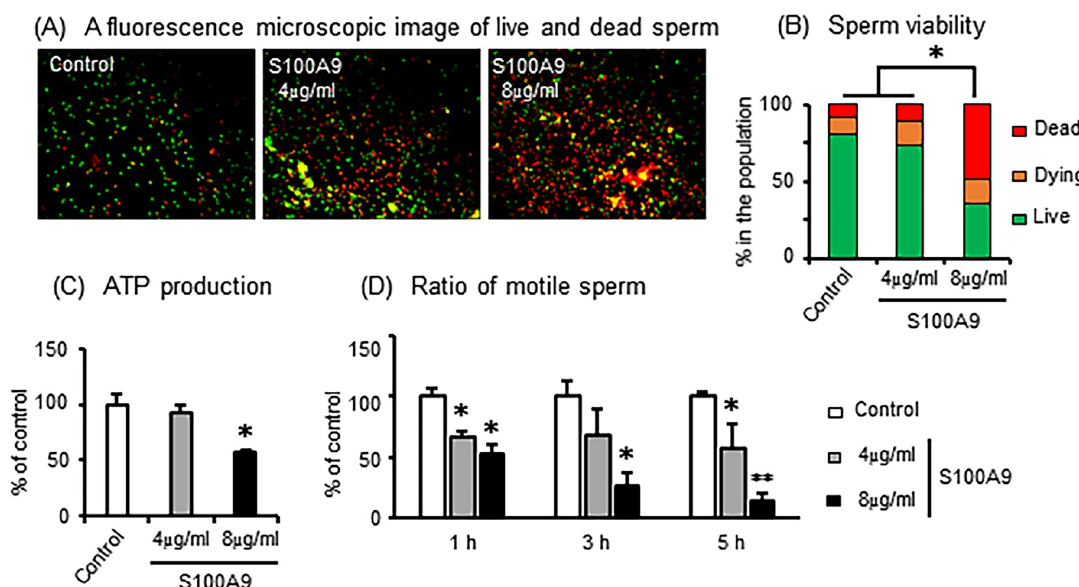
Fig 1. Effects of S100A9 on sperm viability and function. Bovine sperm was treated with 0, 4, and 8 μ g/ml of S100A9 for 5 h. (A) Fluorescence microscopic image of live (green), dying (yellow), and dead (red) sperm. (B) Numbers of sperm in each condition were counted, and the population ratio was calculated. (C) ATP production within sperm was determined after 5 h of treatment with S100A9. (D) Sperm motility was observed using CASA and the ratio of motile sperm was calculated. All values are shown as mean ± SEM. ‘ � or �� ’ indicates significant differences ( P < 0.05 or